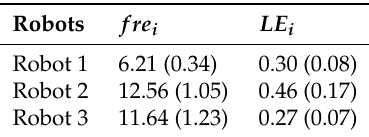
Table 6. Mean (standard deviation) results in communication frequency (%) and localization error (m) based on 30